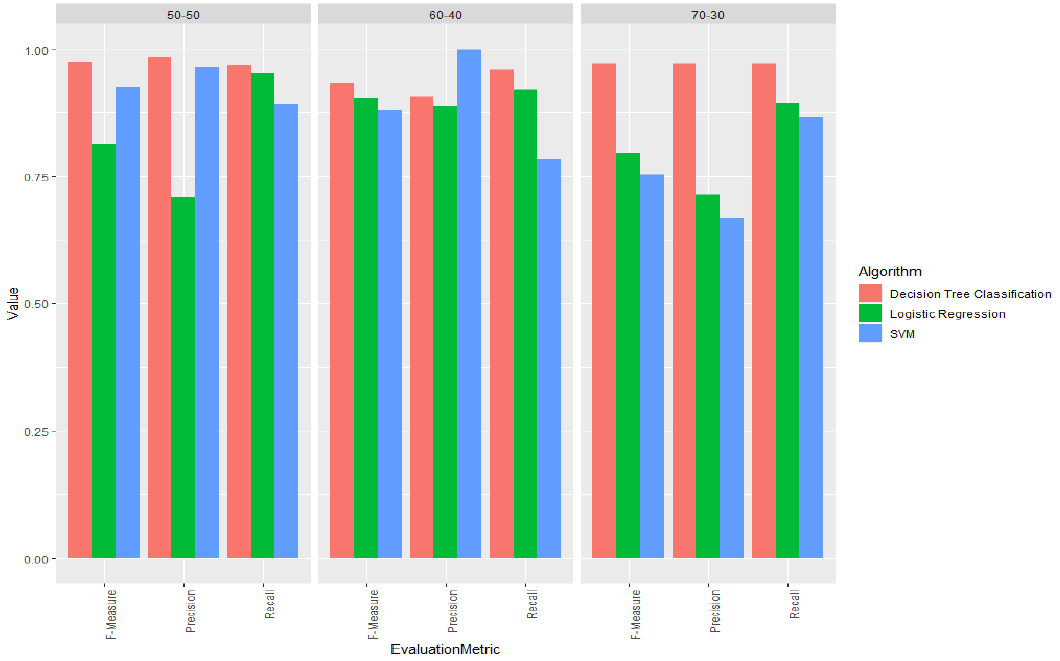
Figure 7. Comparison of precision, recall and f-mesure performance of different classification algorithms on varying training/test sizes.